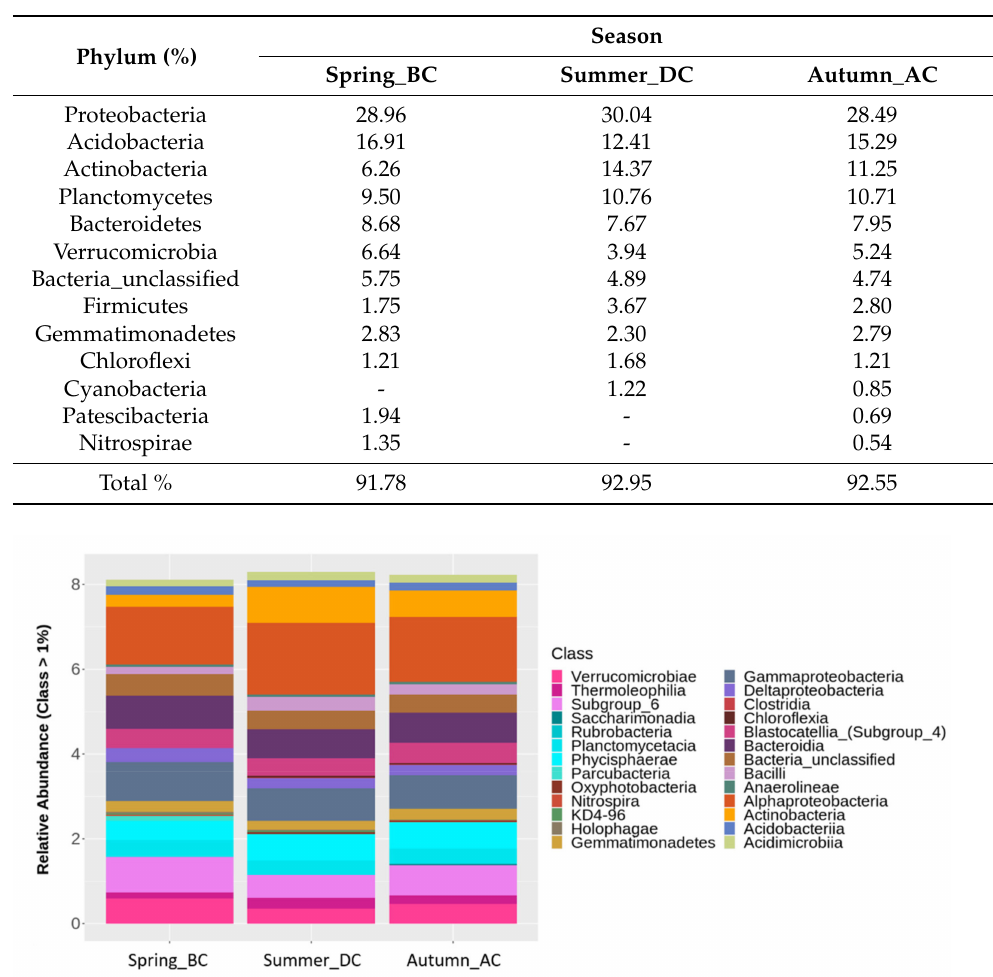
Table 1. Relative abundance (%) of bacterial phyla at rate greater than 1% for Spring_ before cultivation (BC), Summer_during cultivation (DC), and Autumn_after cultivation (AC), across all field sites. The dash symbol indicates absence of the phylum from the respective season.